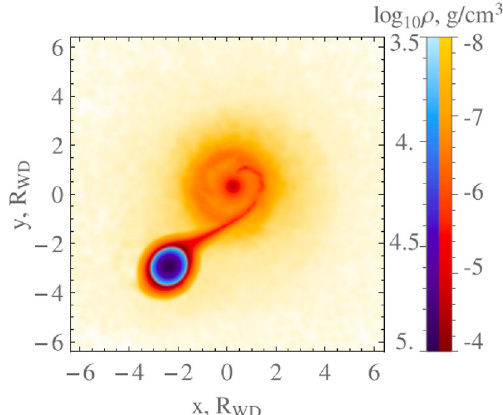
Fig. 13 Hydrodynamical investigation of dynamical stability in a UCXB with a 0 : 15 M (cid:3) WD donor star and a 1 : 4 M (cid:3) accreting NS, in an orbit with an initial eccentricity of 0.04. Plotted here is the mass density in the orbital plane after roughly 13 orbits of RLO. The density plot shows eccentric structures in the accretion disc, the complex character of the fl ow near the circularization radius and a strong density cusp near the NS. The envelope surrounding the binary is sparse but its total mass is signi fi cant compared to the disc. Image reproduced with permission from Bobrick et al. (2017), copyright by the